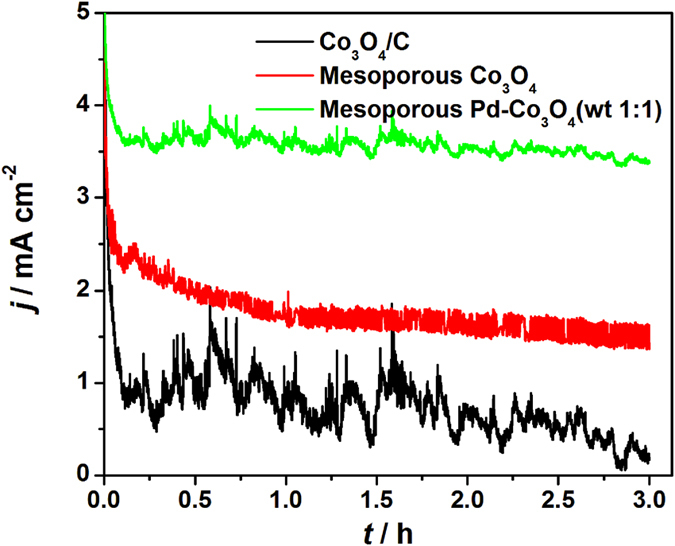
Chronoamperometry curves on Co3O4/C, mesoporous Co3O4 and Pd-Co3O4 (wt 1:1) electrodes in 0.1 mol L−1 KOH at potential of 0.7 V.